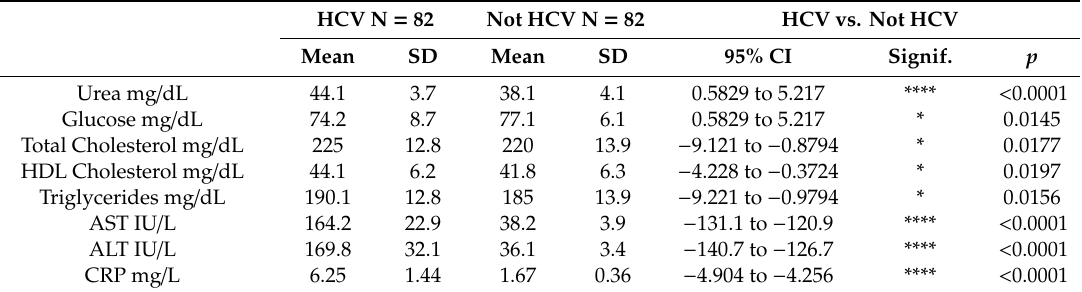
Table 3. Laboratory